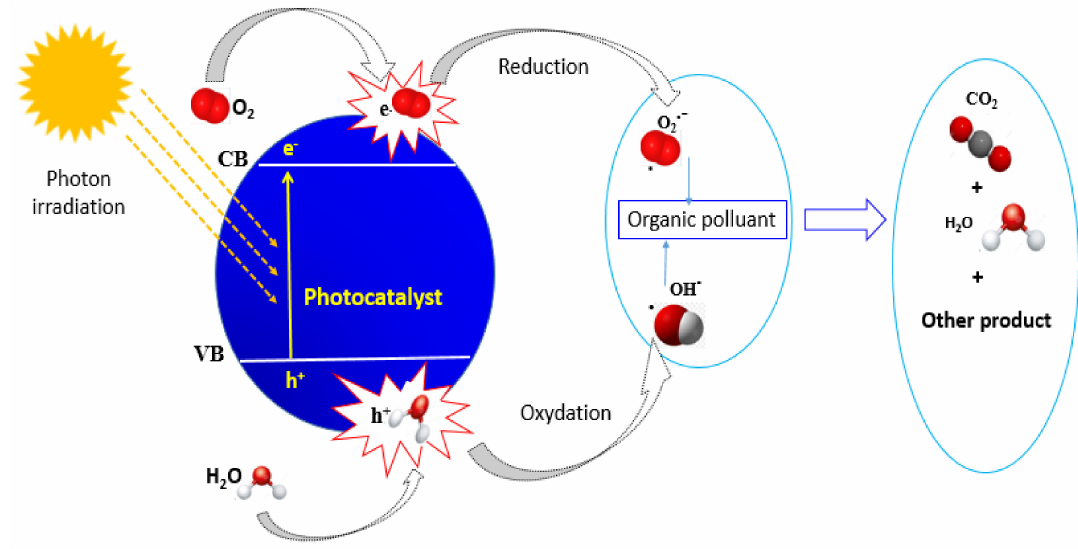
Figure 1. Photocatalysis mechanism.